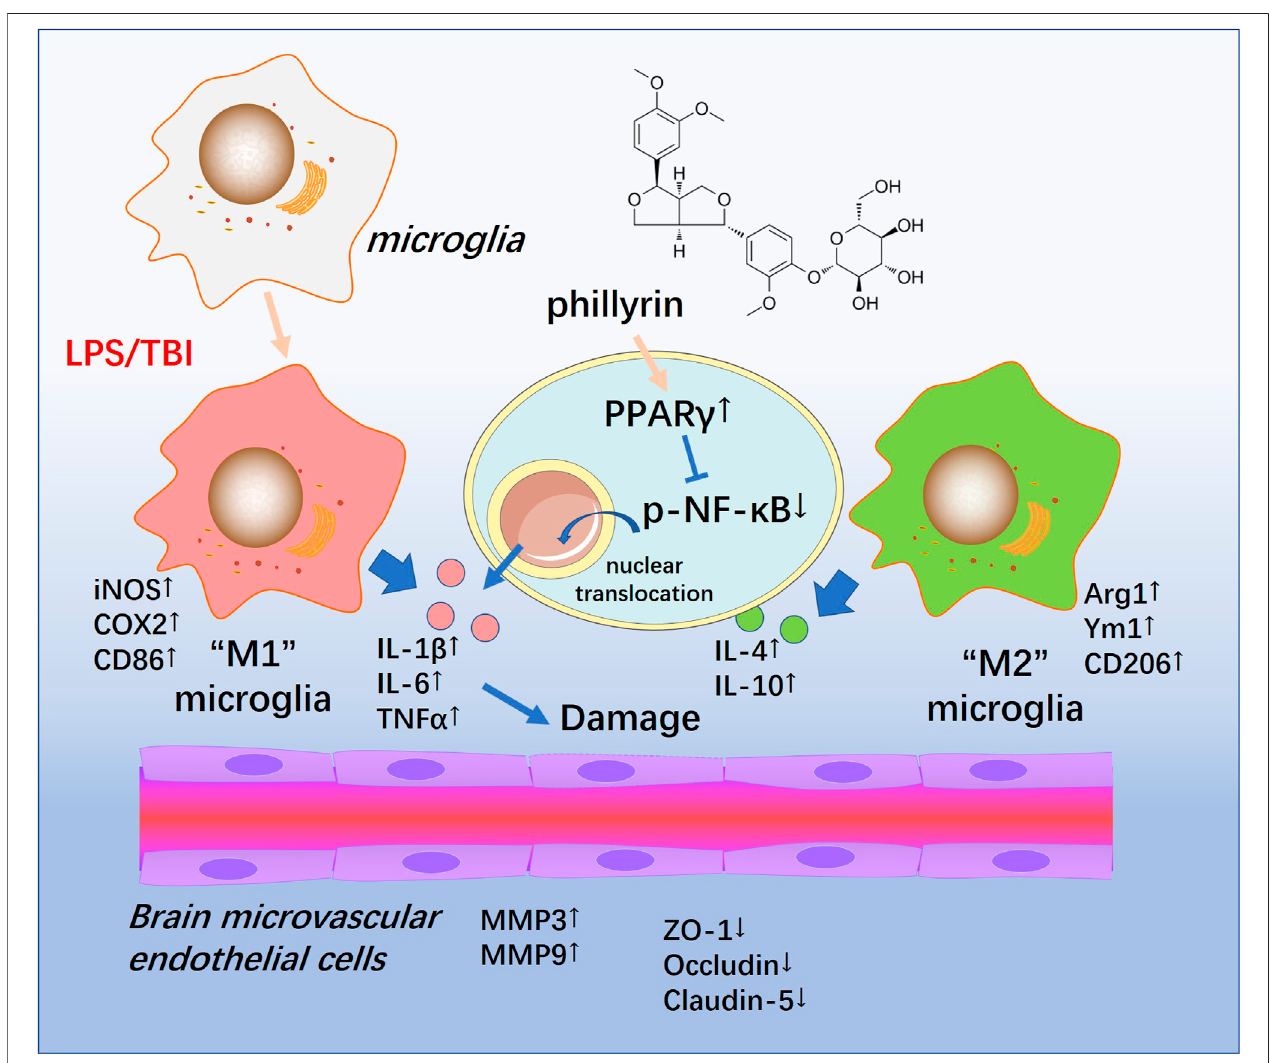
FIGURE 8 | Schematic illustration of the possible mechanisms of Phi on TBI-mediated BBB damage. As illustrated, microglia become activated into an in fl ammatory state and release plenty of pro-in fl ammatory factors such as TNF- α ,IL-1 β , and IL-6 in the lesions of TBI. At the same time, phospho-NK- κ B p65 is upregulated and translocates into the nuclei. Phi inhibits the nuclear translocation of phospho-NK- κ B p65 by enhancing the PPAR γ signaling pathway, promoting microglial “ M2 ” polarization. Therefore, Phi mitigates BBB injury following TBI.